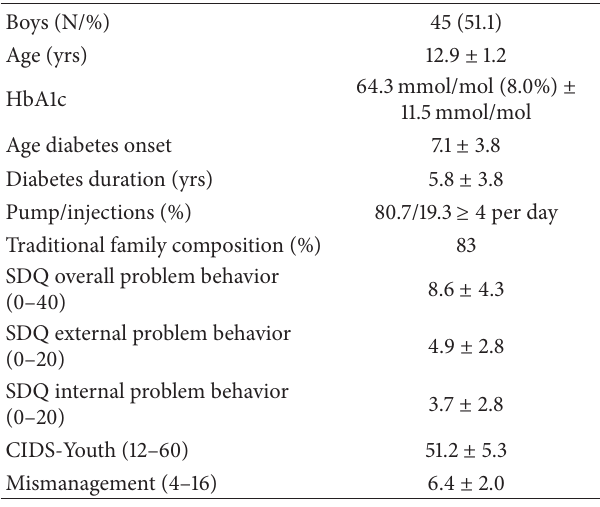
Table 1: Characteristics of participating